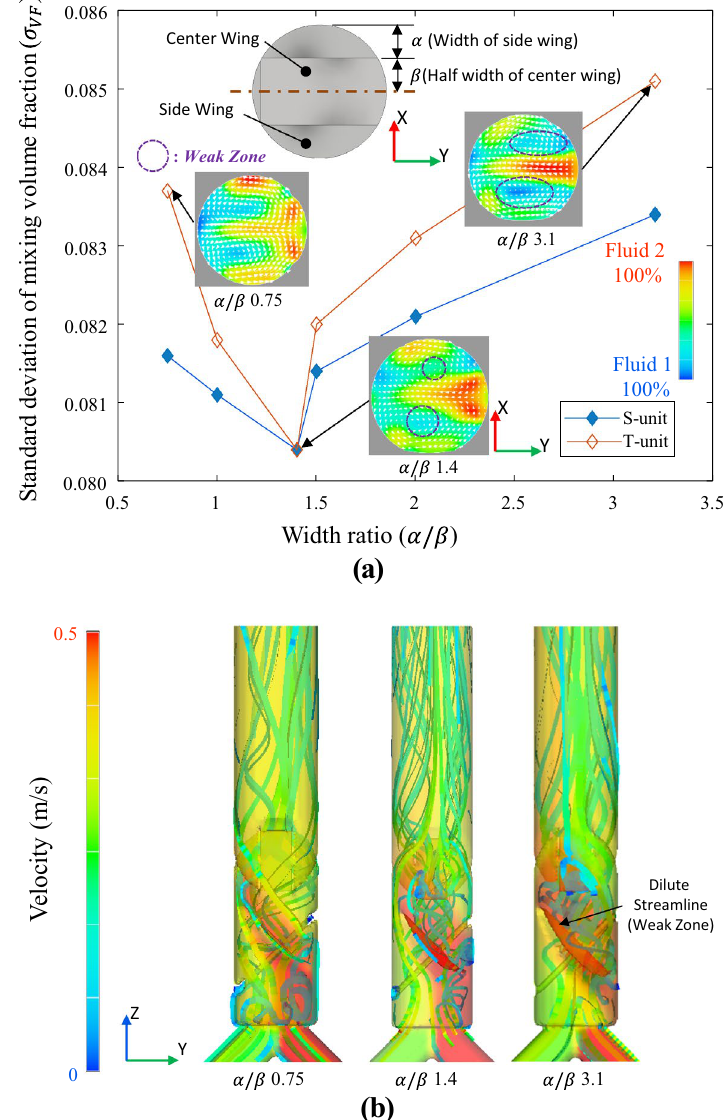
Figure 6. Mixing performance according to the ratio of α/β; as the α/β is par from 1.4, a small area with a high- velocity distribution is generated; ( b ) streamlines according to the ratio of α/β. As the α/β increases, the size of weak-zone also increases (at α/β =